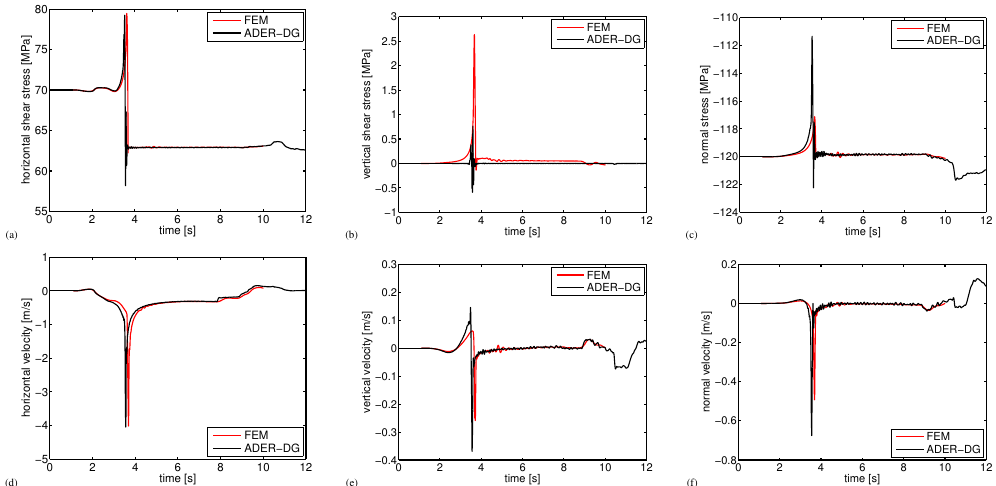
Fig. 13. Stresses and velocities of TPV6 at a surface location on the near side of the fault at 0 km along-strike and above the hypocenter. The